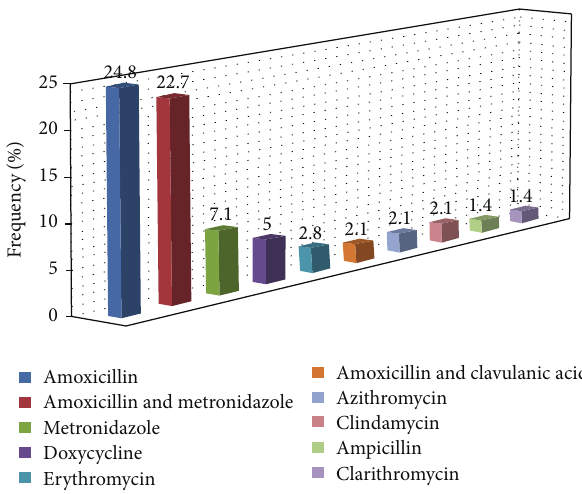
Figure 4: Participants’ responses: The use of systemic antibiotics as part of the postoperative care following regenerative